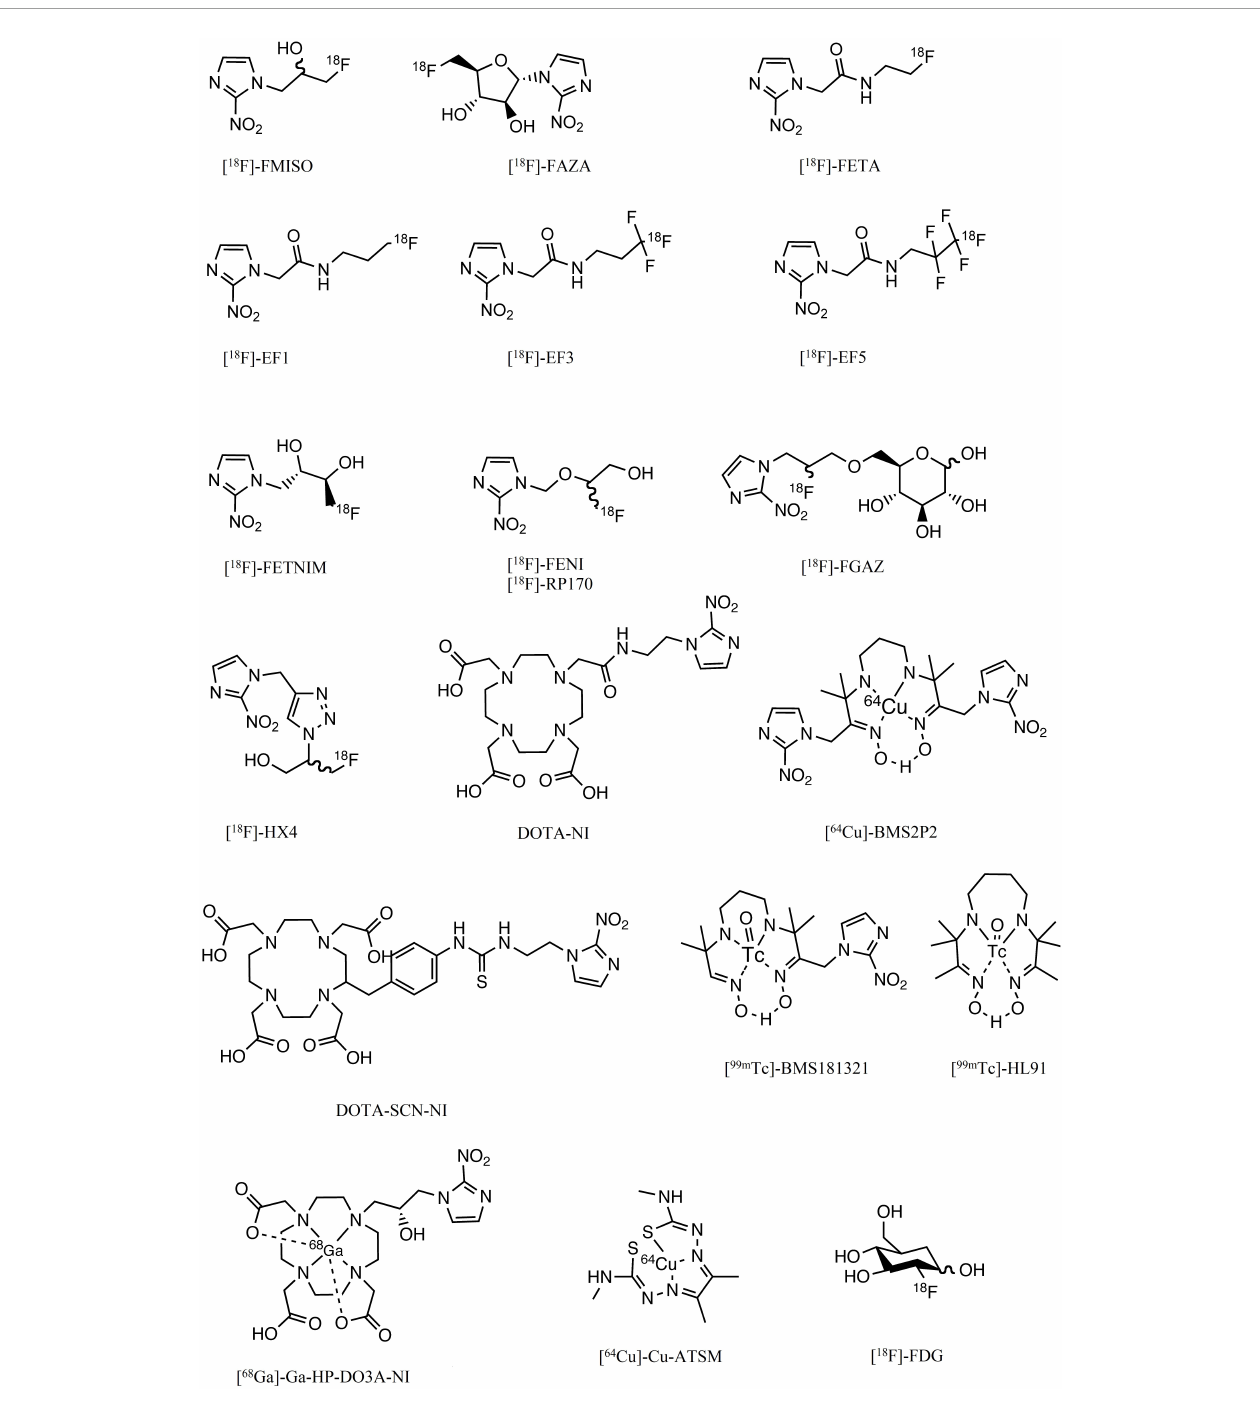
PET denotes treatment resistance in HNC and is a biomarker for selection of patients at high risk of loco-regional recurrence after treatment